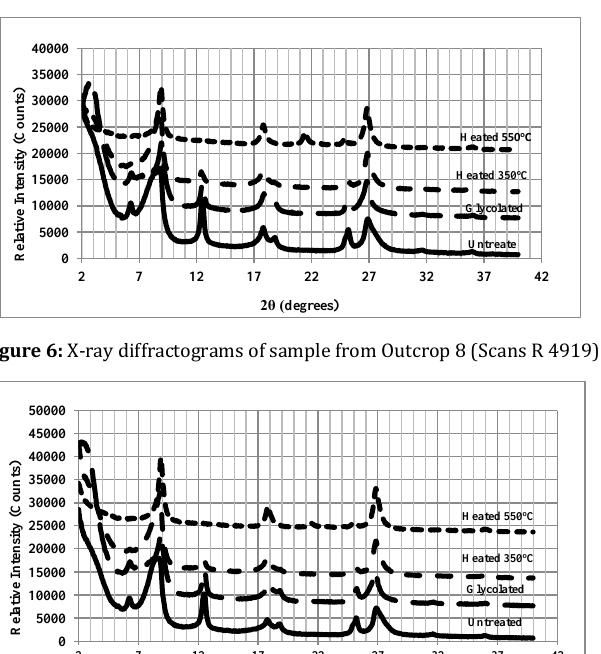
Figure 5: X-ray diffractograms of duplicate sample from Outcrop 6 (Scans R 4921)